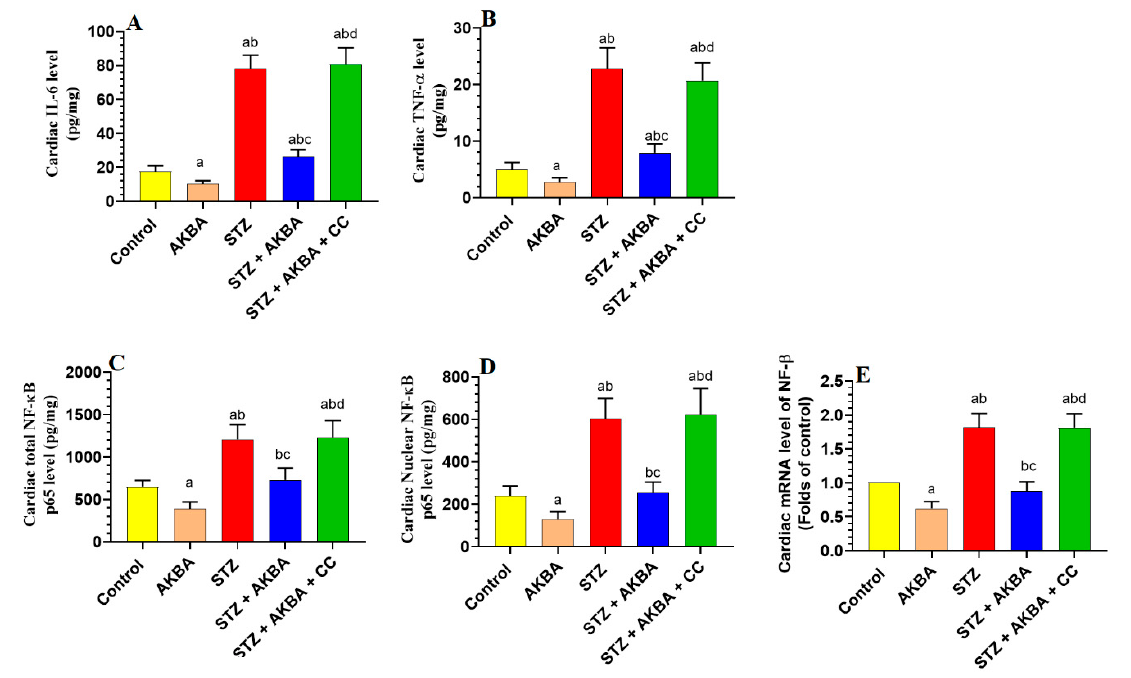
Figure 7. Total levels of interleukin-6 (IL-6) ( A ) and tumor necrosis factor- α (TNF- α ) ( B ), as well as total, nuclear, and mRNA levels of NF- κ B p65 ( C – E ) in the left ventricles (LVs) of all rat groups. Data were analyzed with one-way ANOVA followed by Tukey’s test. Values are presented as mean ± SD (n = 8/group). Data were considered significantly different at p < 0.5. a: significantly different as compared to control rats; b: significantly different as compared to AKBA-treated rats; c: significantly different as compared to STZ-diabetic rats; d: significantly different as compared to STZ + AKBA-treated rats. CC–compound C (a selective AMPK inhibitor).